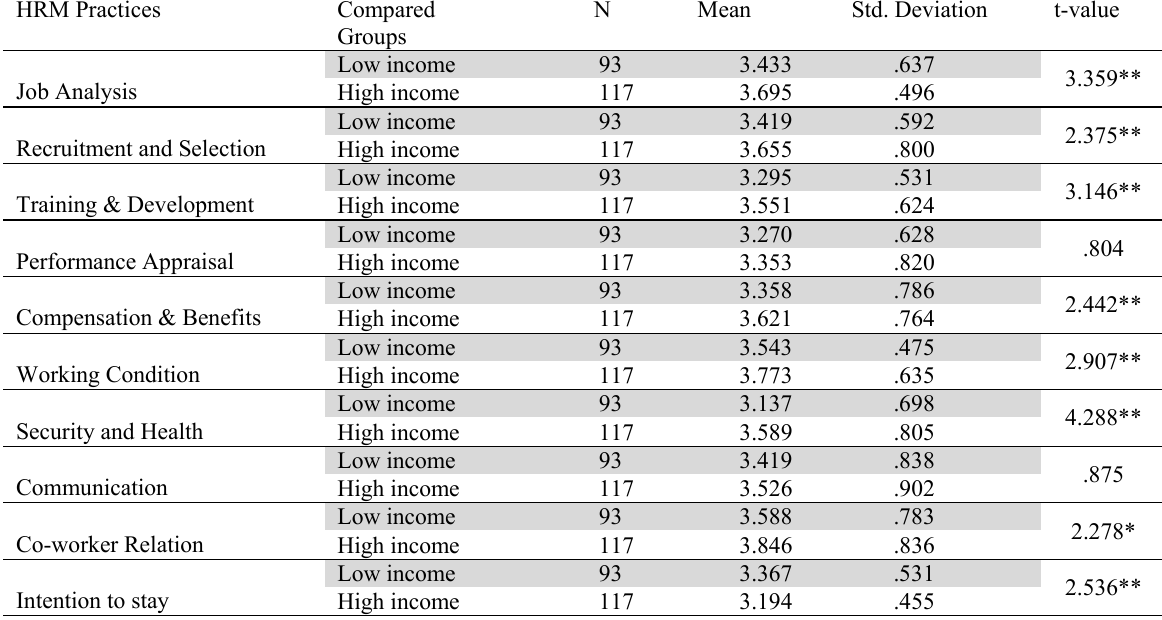
Mean, SD and t-value of low and high income groups of telecom employees on HRM